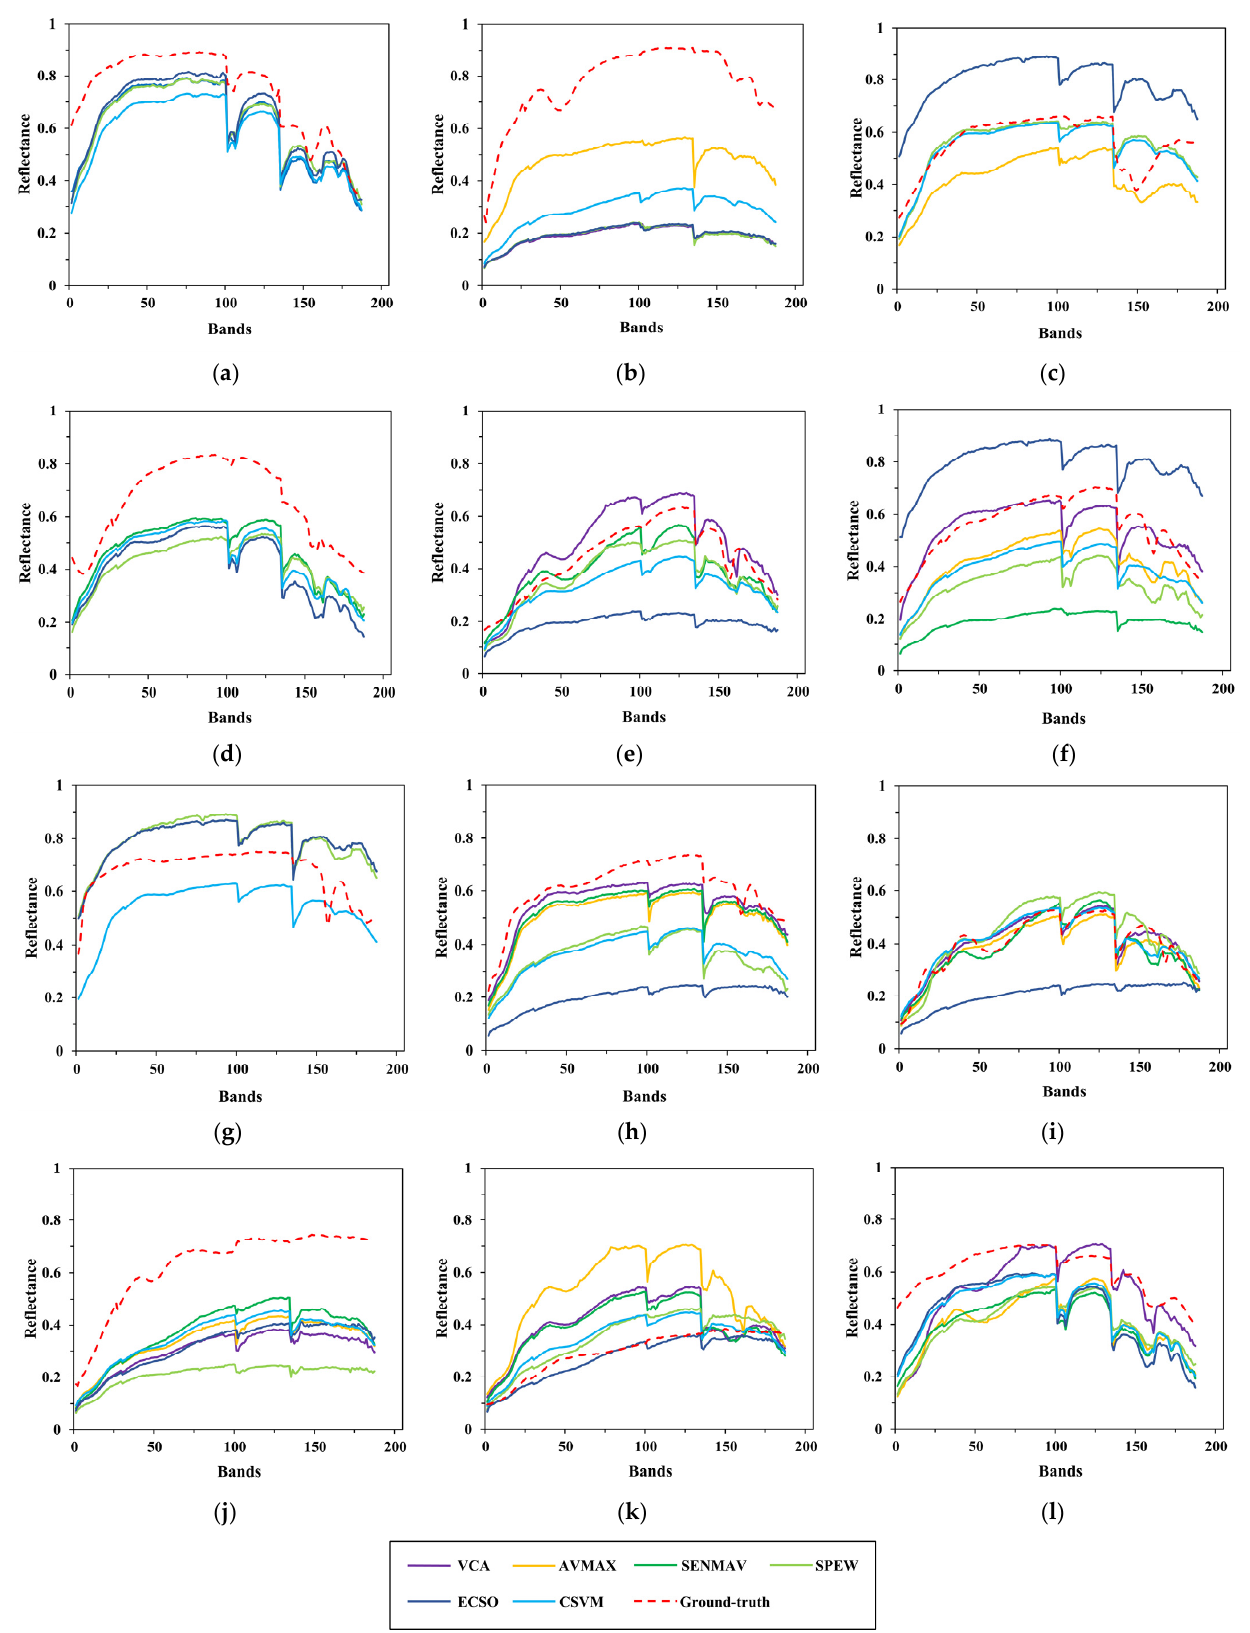
Figure 12. Comparison between the estimated and ground-truth endmember spectral signatures on Jasper Ridge. ( a ) Tree; ( b ) water; ( c ) soil; ( d ) road.